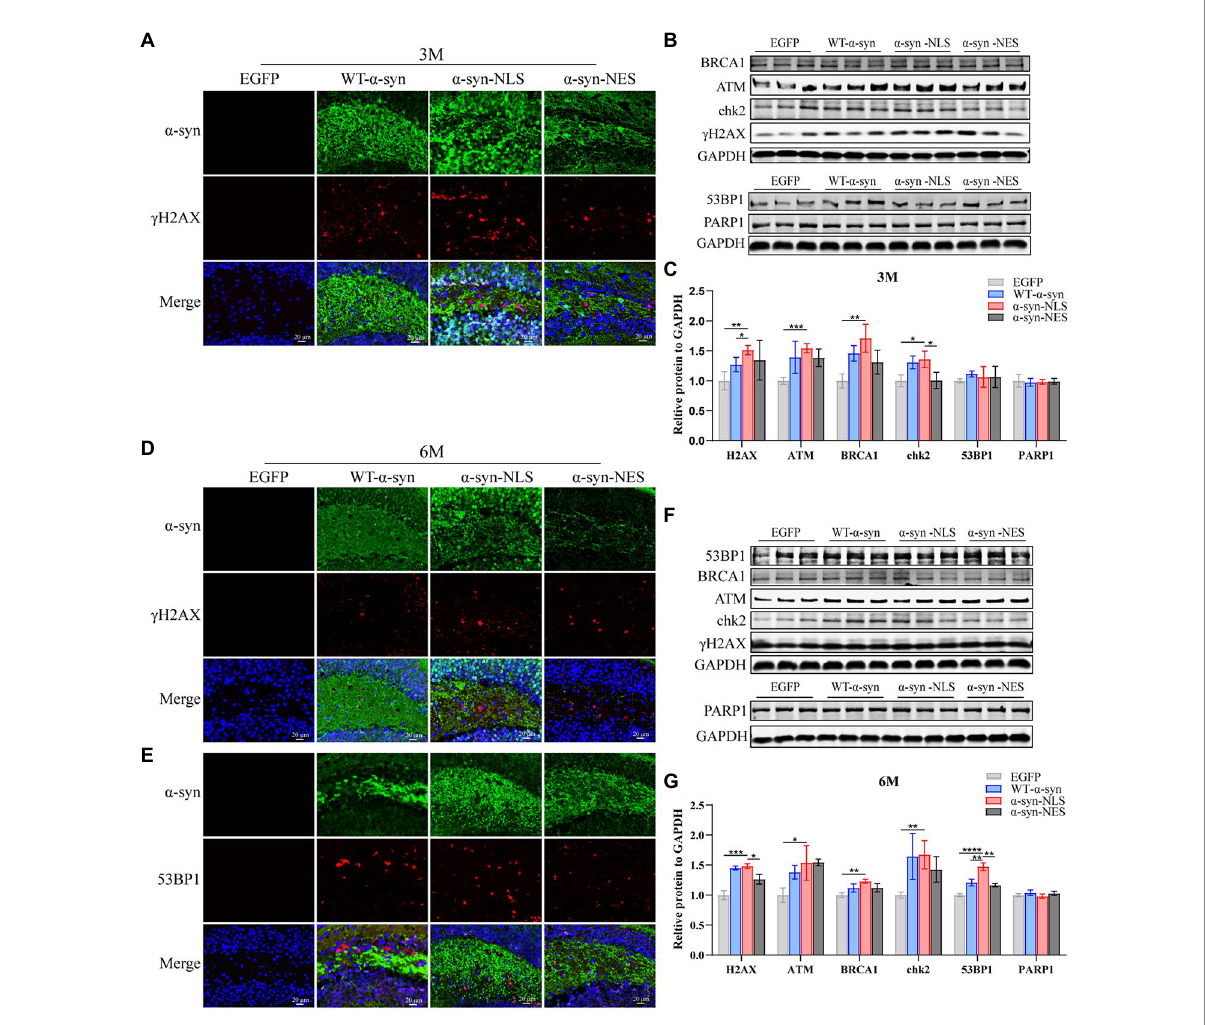
FIGURE 6 DNA damage caused by nuclear localized α -syn aggravates over time. (A,D) Immunofluorescence staining of mouse hippocampus with α -syn (green) and γ H2AX (red) antibodies at months 3 and 6 after virus injection; DAPI was used to stain all nuclei (blue). (B,F) Western blot of the hippocampus tissues of mice with antibodies to γ H2AX, ATM, BRCA1, chk2, 53BP1, and PARP1 ( n = 3). (C,G) Relative levels of proteins (ratio to GAPDH) in western blot are presented (n = 3). (E) Immunofluorescence staining of mouse hippocampus with α -syn (green) and 53BP1 (red) antibodies at month 6 after virus injection; DAPI was used to stain all nuclei (blue). * p < 0.05, ** p < 0.01, *** p < 0.001, **** p <